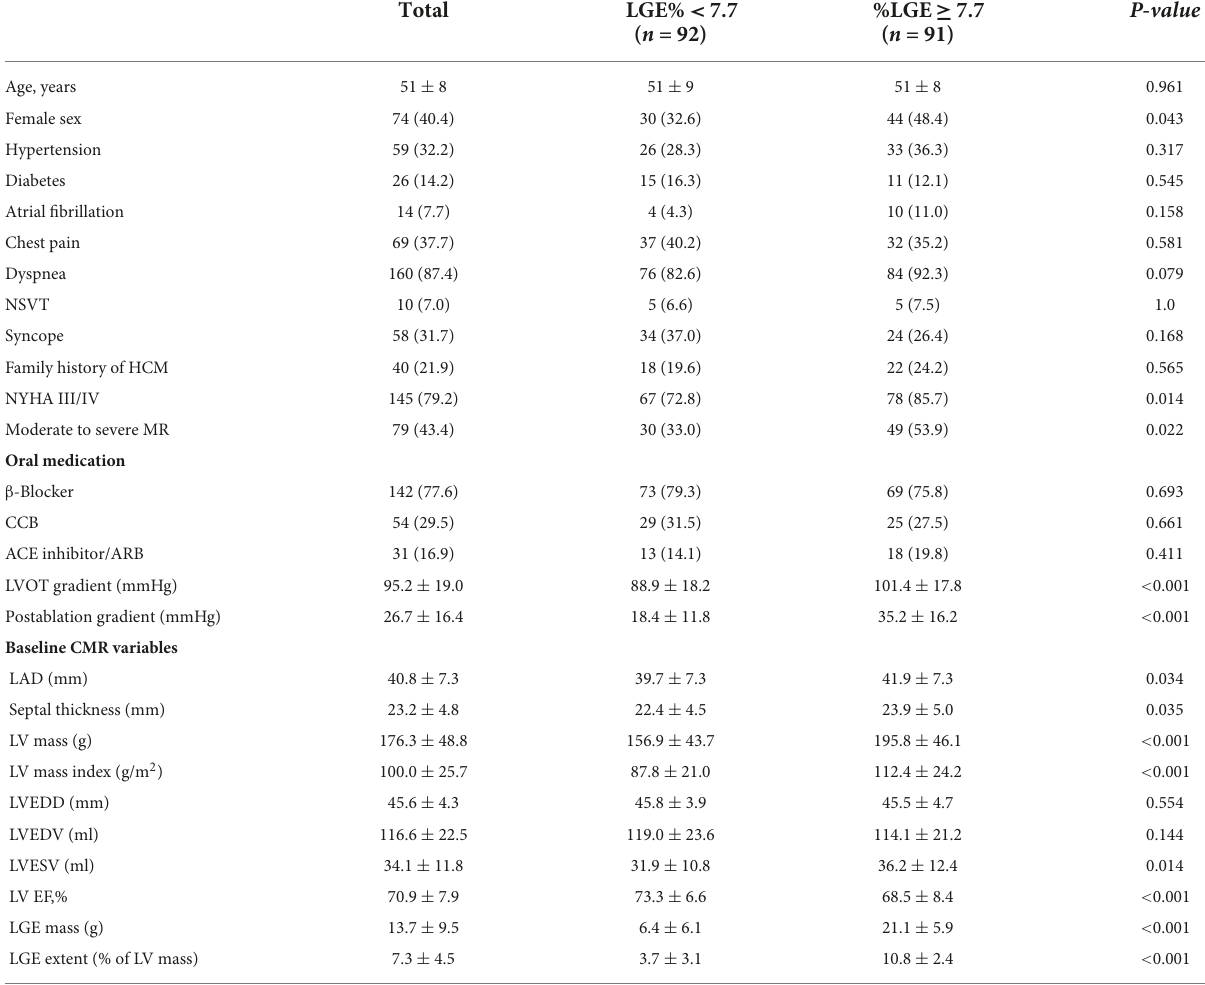
TABLE 1 Comparison of baseline clinical characteristics in patients with myocardial fibrosis classified by the median LGE (% of LV mass). Total LGE% <